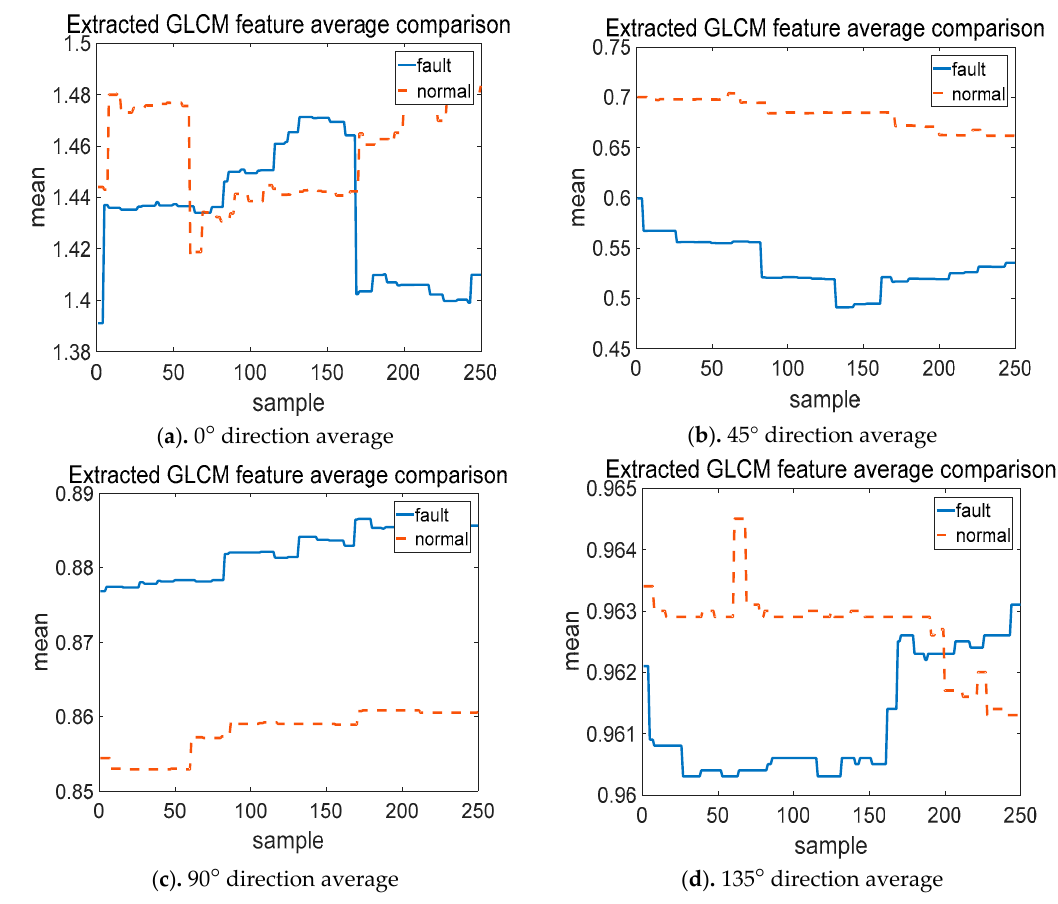
Figure 7. GLCM feature average comparison chart.